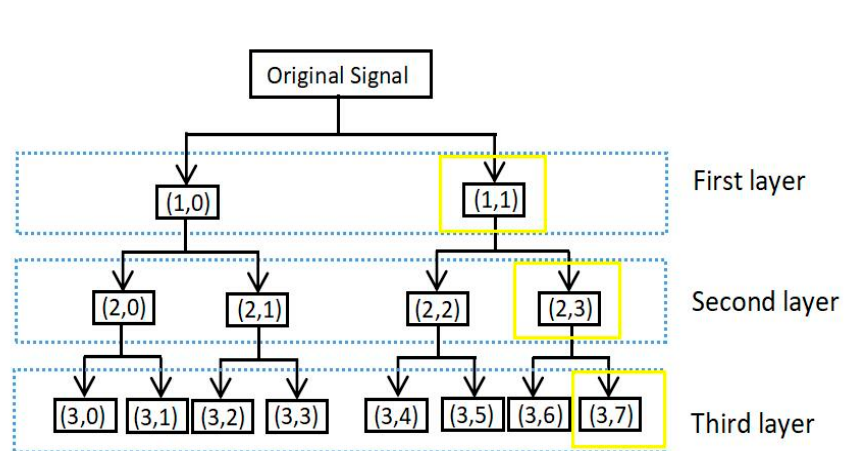
Figure 11. Flow chart of wavelet packet decomposition and reconstruction.